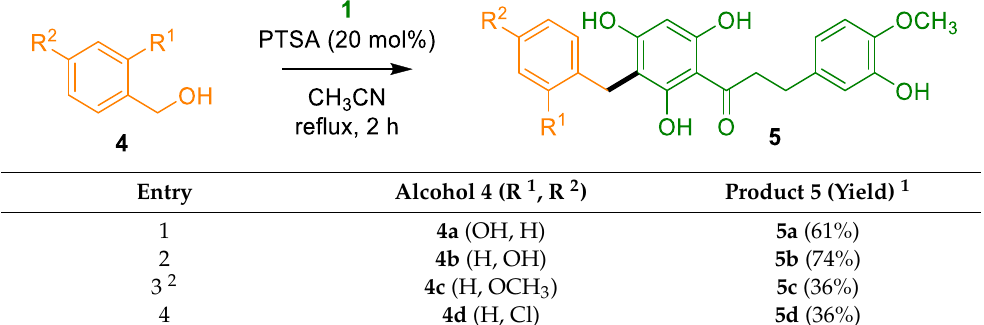
Table 2. Catalytic benzylation of dihydrochalcone 1 .